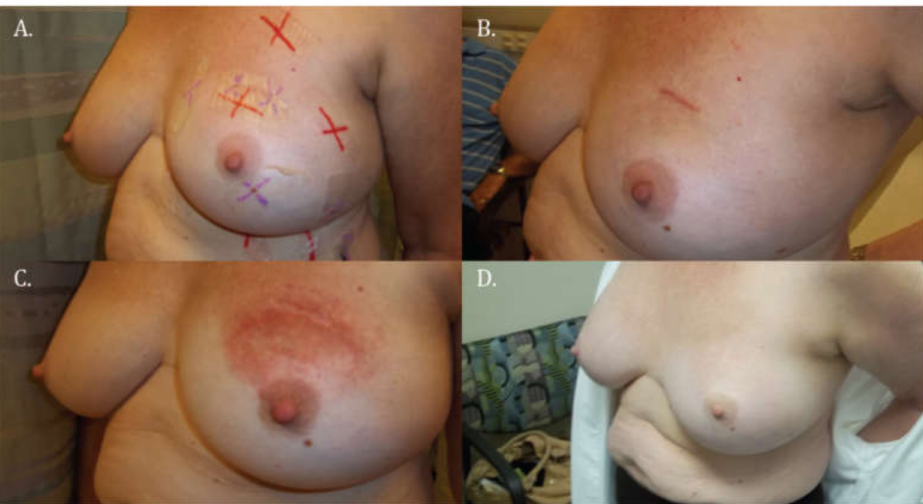
Figure 3. Medical photographs of one patient at selected follow-up visits showing a common skin reaction to proton APBI. No visual changes at ( A ) the end of radiotherapy or at ( B ) the two-week visit. ( C ) Patchy erythema in >50% of the treated skin area at six weeks, which ( D ) resolved showing no visual changes at 6 months. APBI, accelerated partial breast irradiation.